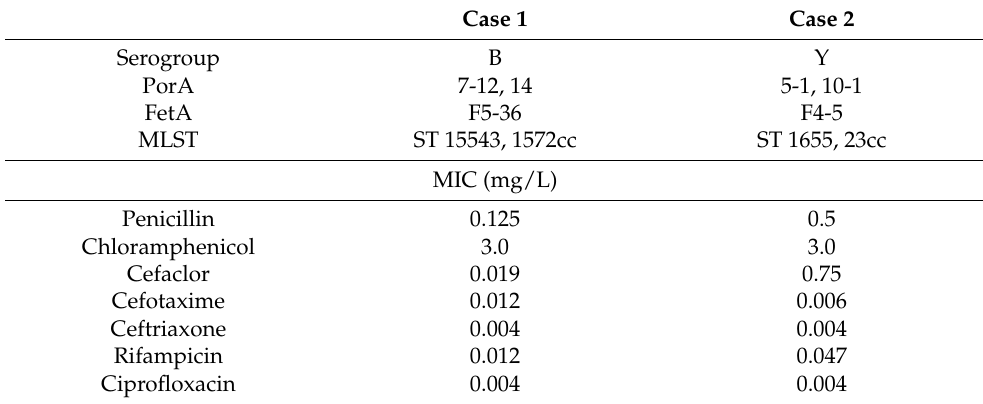
Table 1. Meningococcal characteristics of the two cases. Case 1 Case